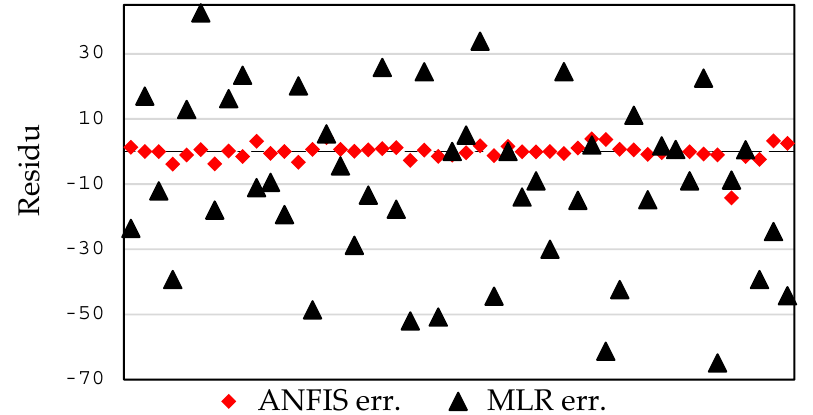
Figure 5. Comparison between the residual error distribution by ANFIS and MLR.